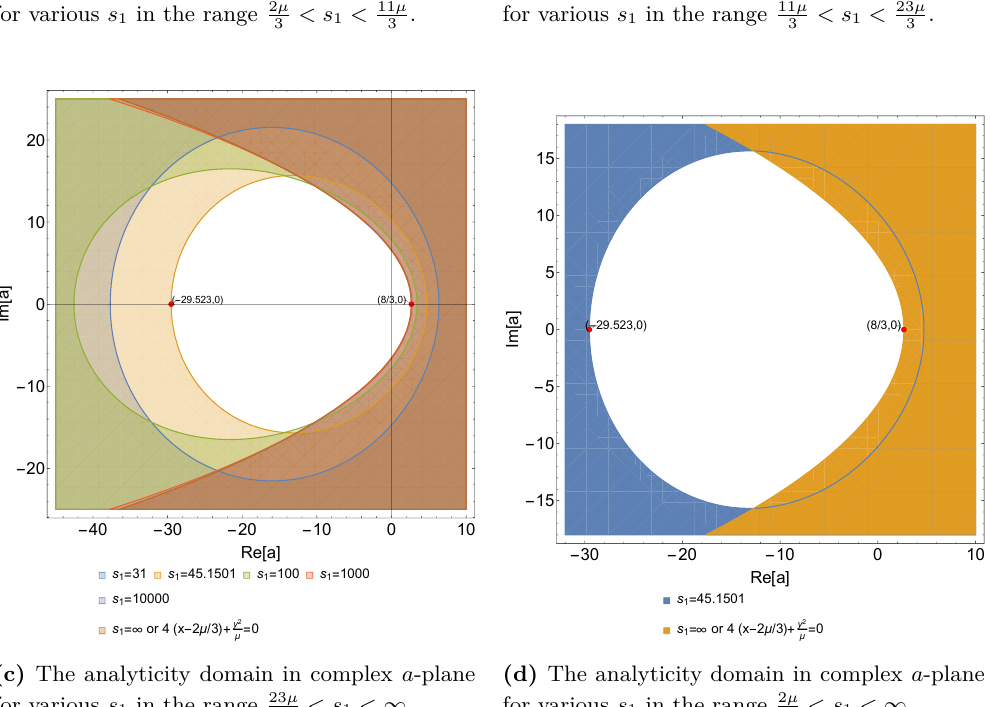
(b) The analyticity domain in complex a -plane for various s 1 in the range 11 µ